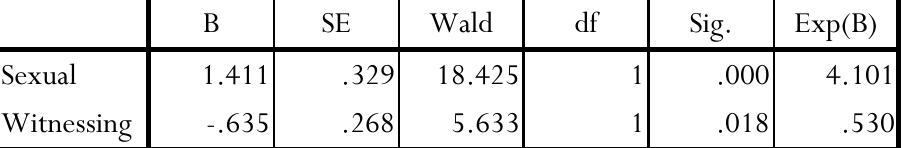
Table 14: Cox Regression of Number of Victimizations on Onset of